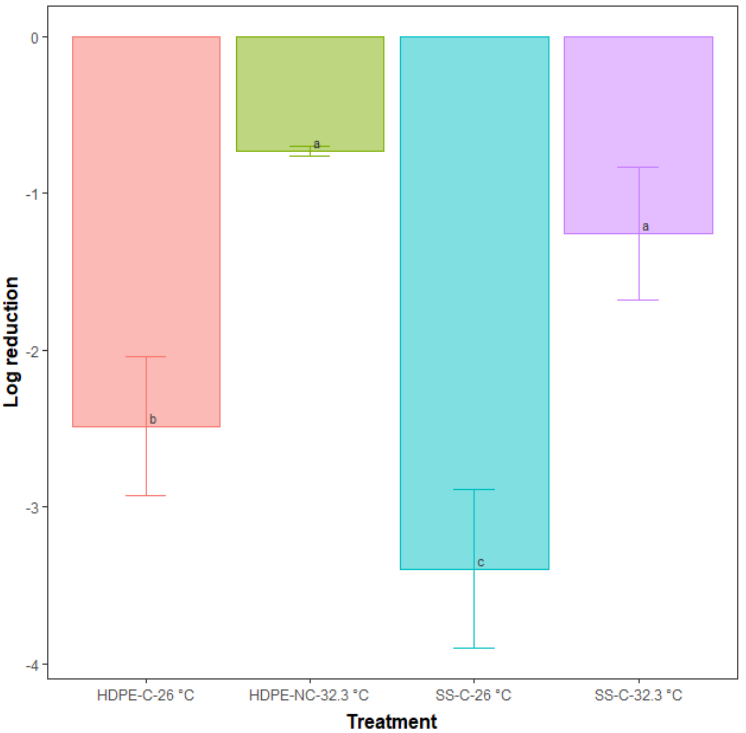
Figure 8. Logarithmic reduction of E. coli after 3 h of treatment with the P25 TiO 2 -coated materials with temperature control at 26 °C (HDPEC-F, SS-C-F) and without temperature control at 32.3 °C (HDPE-C-NF, SS-C-NF). Error bars represent ± one standard deviation of three measurements (n = 3). Treatments with the same letter are not significantly different ( p > 0.05).